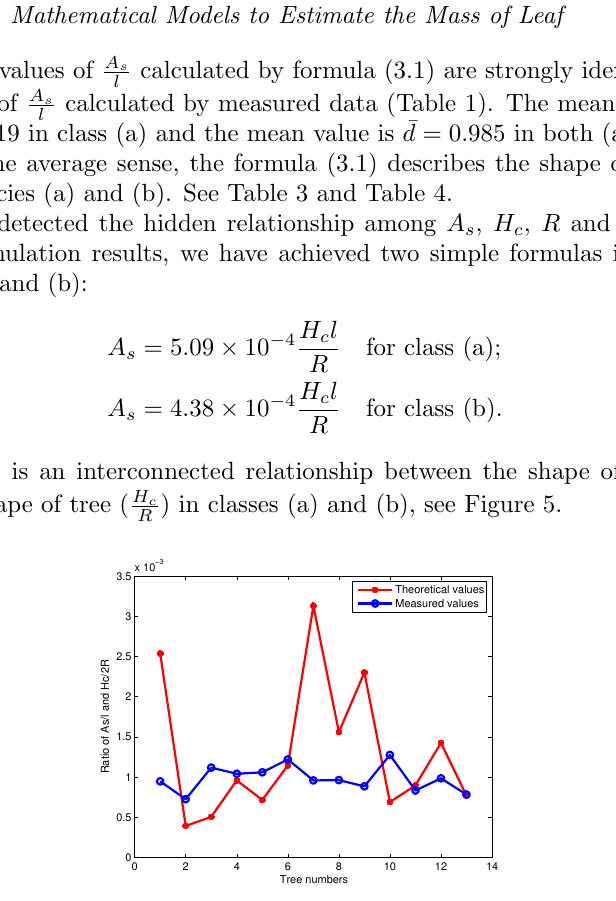
Figure 5. Comparison of theoretical values and measured values for the ratio of A s /l and H c / 2 R . The star points (red) and hollow circles (blue) sketch the theoretical values and measured values for the ratio of A s /l and H c / 2 R ,